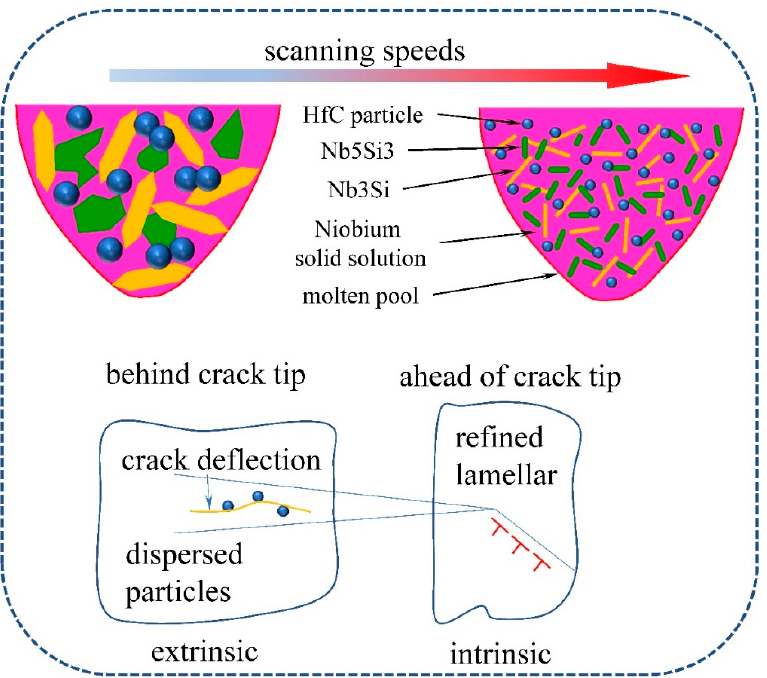
Figure 7. The schematic diagram of the toughening mechanism of Nb18Si5HfC alloy.